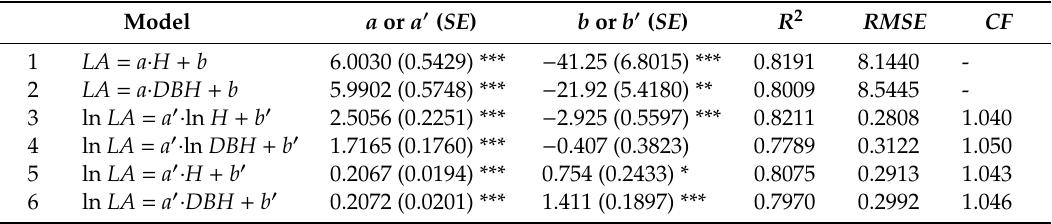
Table 2. Allometric relationships between LA and diameter at breast height ( DBH ) or tree height ( H ). SE = standard error; R 2 = the coe ffi cient of determination; RMSE = the root-mean-square error; CF is the logarithmic correction factor. The LA unit of the equations was converted from cm 2 to m 2 to avoid large regression parameters.